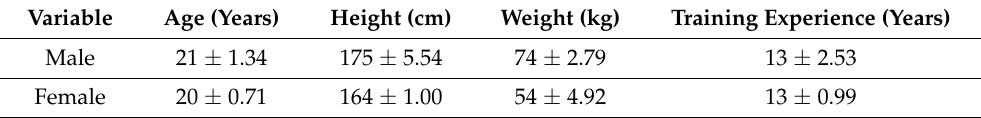
Table 1. Participants ( n = 36) characteristics and anthropometric measures (Mean ±